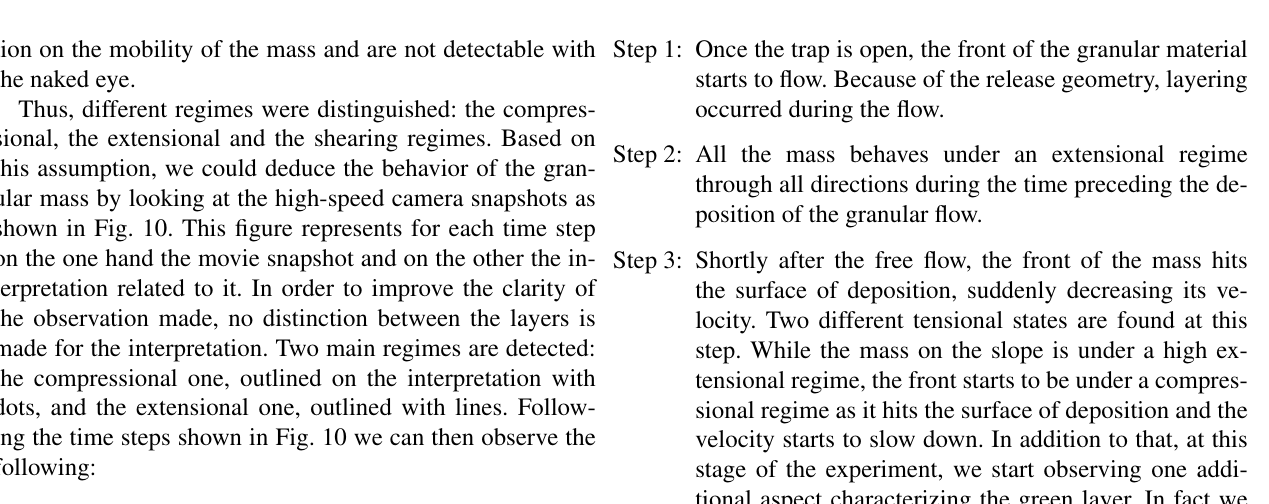
Figure 8. (a) Portion of the back of a deposit after post-processing and (b) detailed mapping of the back of the deposit. Strike-slip faults are numerous at the back, cutting normal faults. (c) The whole